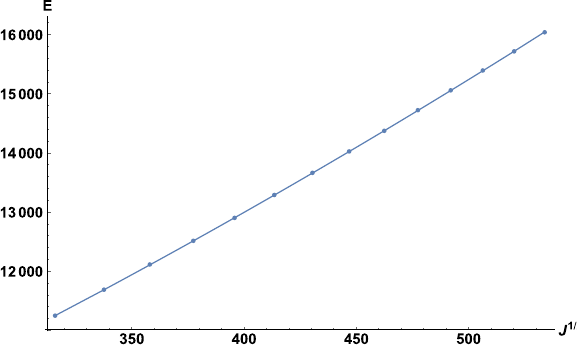
√ Fig. 9 Energyvs J 3 foravortonclosetothecritical ω for Q =